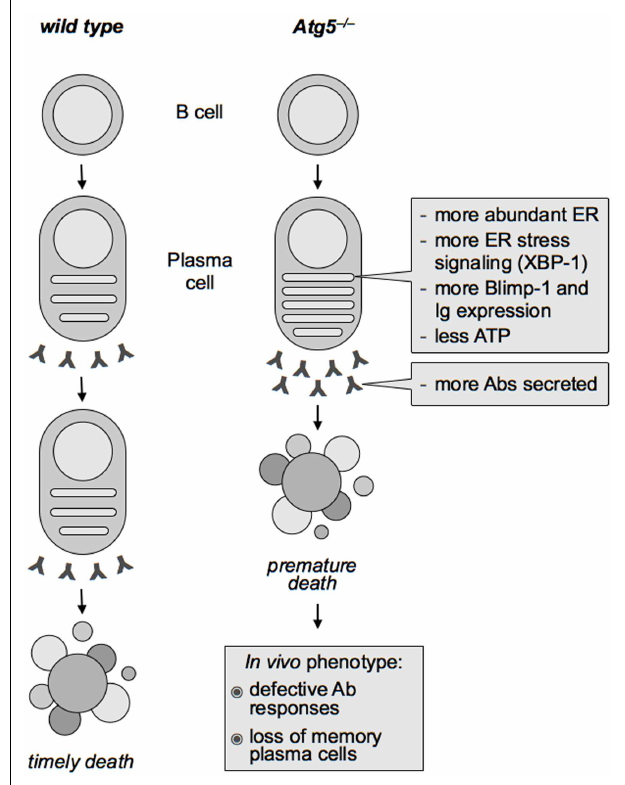
FIGURE 1 | Effect ofAtg5 deficiency on plasma cell differentiation and Ab immunity . In differentiating plasma cells, autophagy limits the expansion of the endoplasmic reticulum (ER), providing the first physiological case of mammalian ER-phagy. As a result, Atg5 − / − plasma cells show more abundant ER than wild type counterparts and more intense ER stress signaling (including higher expression of the essential plasma cell transcription factor, XBP-1), which in turn enhances the expression of the key plasma cell transcriptional regulator PRDM1/Blimp-1 and of immunoglobulins (Ig). Hence, despite increased Ig production, autophagy-deficient plasma cells have less ATP and live a shorter life, yielding defective Ab responses in vivo